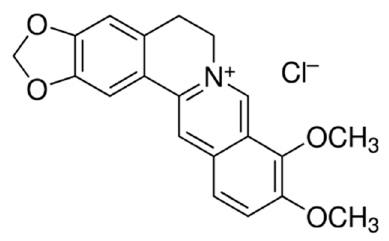
Figure 1. The chemical structure of berberine (BBR).